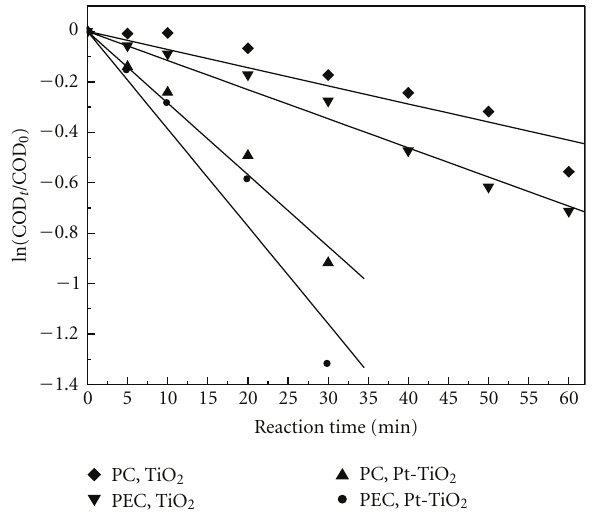
Figure 10: Logarithm of formic acid normalized COD concentra- tion as a function of treatment time for the four